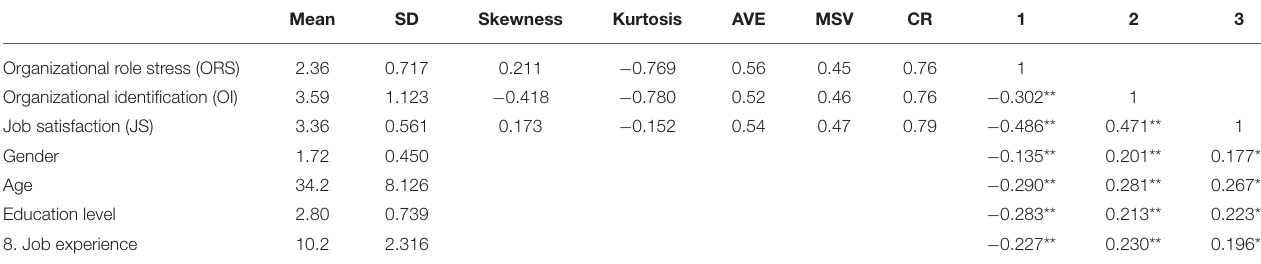
TABLE 1 | Basic statistics about the variables.